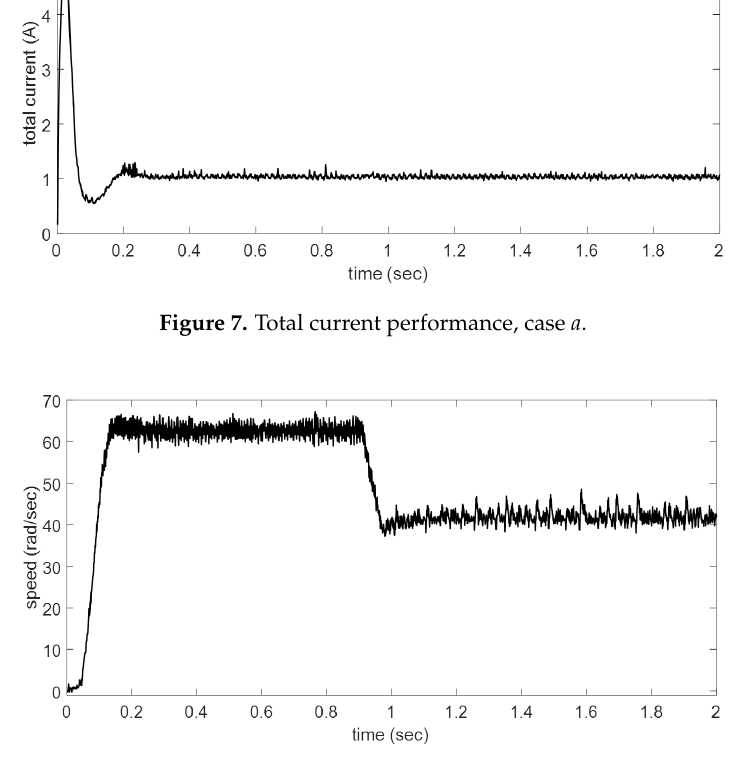
Figure 8. Rotor speed performance for reference tracking, case b